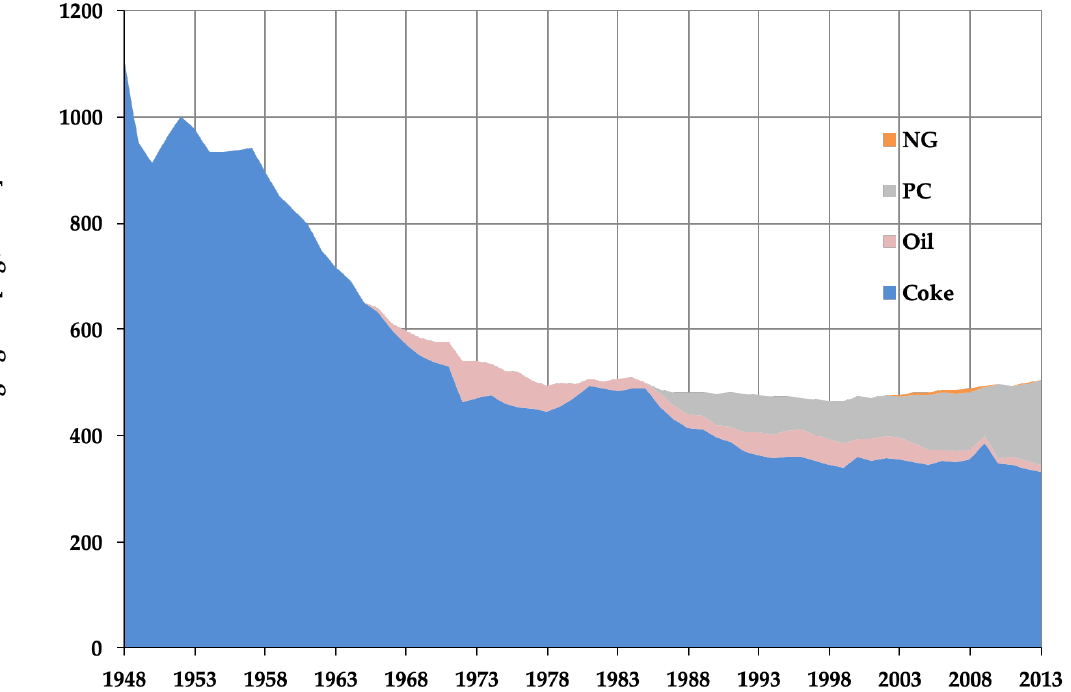
Figure 5. Historical evolution of reducing agent’s consumption in the blast furnace (BF) in Europe (European Blast Furnace Committee, courtesy of VDEh).